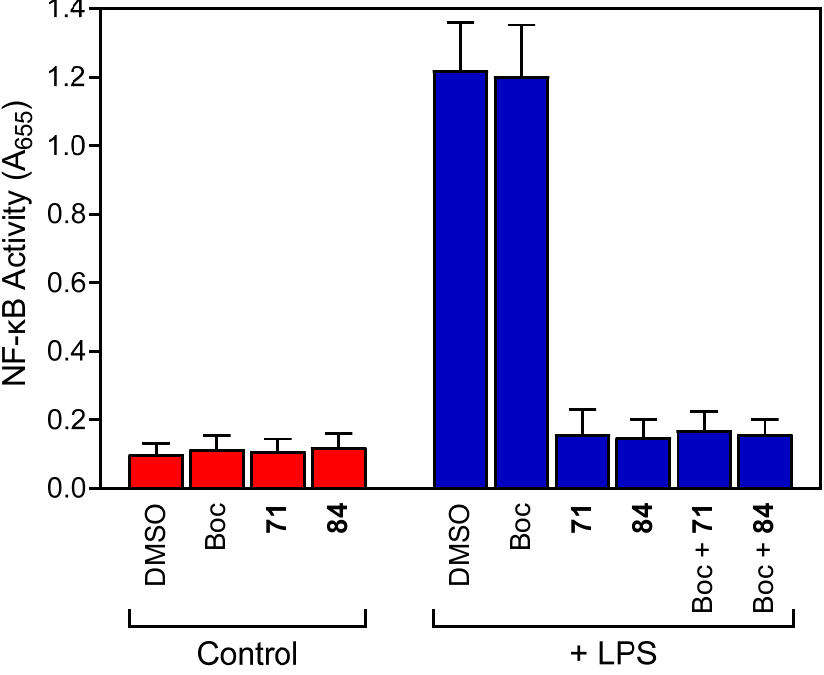
Figure 7. The effect of Boc-MLF on the anti-inflammatory activity of compounds 71 and 84 . THP1- Blue cells were pretreated for 15 min with buffer or 25 µ M Boc-MLF, followed by treatment of 30 min with DMSO or 5 µ M of compounds 71 and 84 . The cells were then incubated for 24 h with media (control) or 250 ng/mL LPS, as indicated. NF- κ B activation was monitored by measuring the secreted alkaline phosphatase activity spectrophotometrically in the cell supernatants (A 655 ), as described. The data are presented as the mean ± S.D. of triplicate samples from one experiment that is representative of three independent experiments.